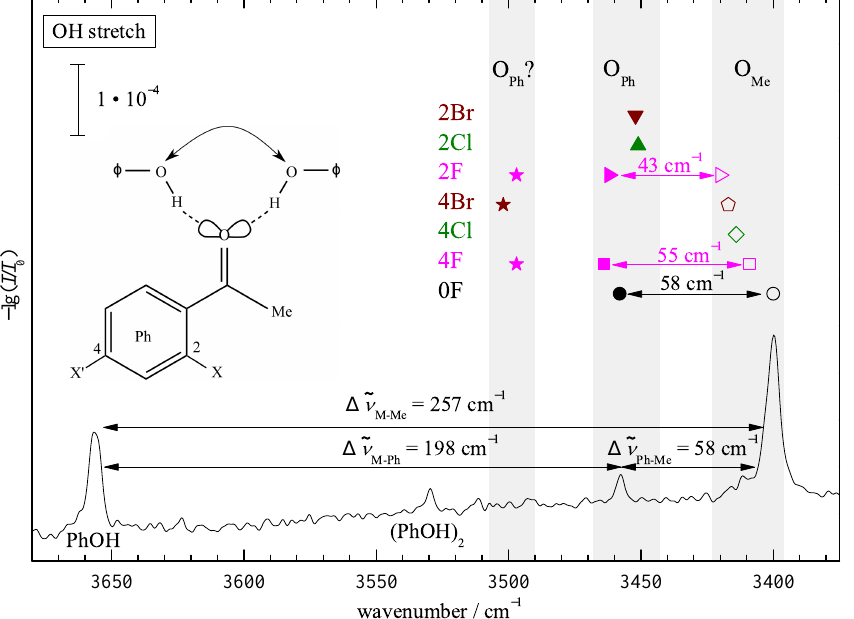
Figure 2. OH stretching FTIR spectrum of a coexpansion of phenol (PhOH) with acetophenone (0F) showing the phenolic OH stretching signals. The index Ph or Me indicates the docking side. The corresponding positions for halogenated acetophenones are summarized as symbols in grey corridors of 20 to 30cm − 1 for each side. Both docking sides are observed (double arrows) only for 0F, 2F, and 4F. See text for further